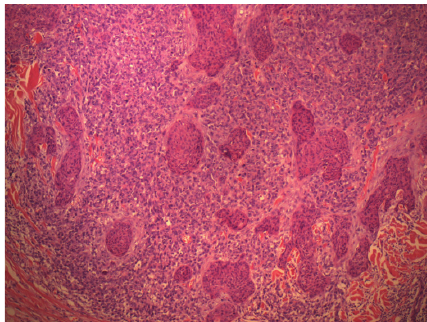
Figure 2: Squamous islands and undifferentiated cells H&E × 40.